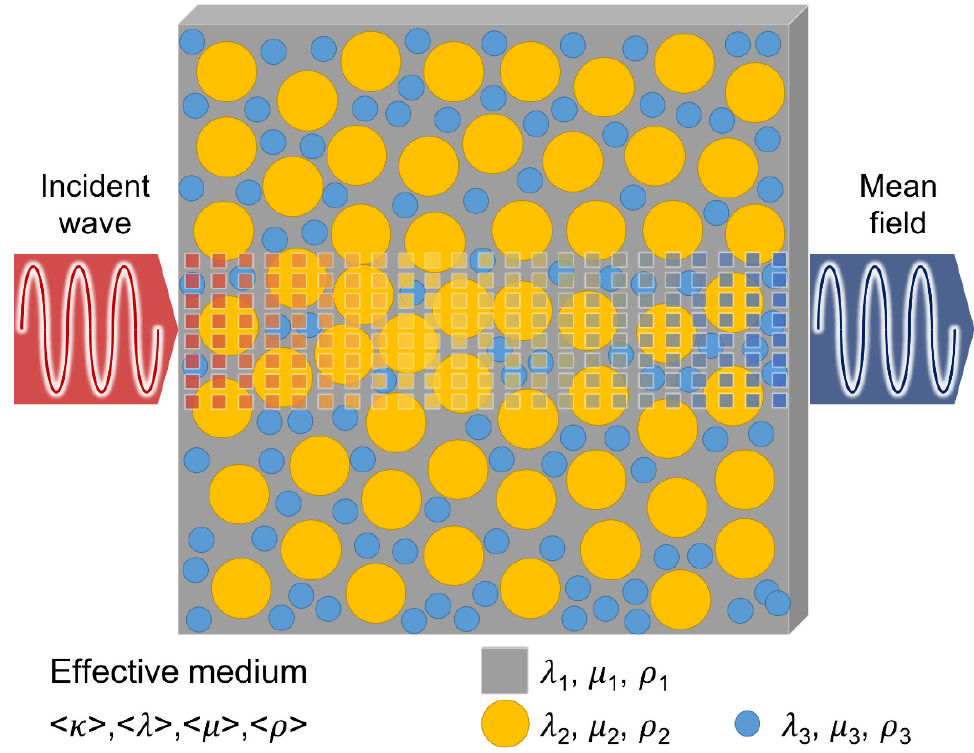
Figure 1. Schematic of wave propagation in an inhomogeneous effective medium.